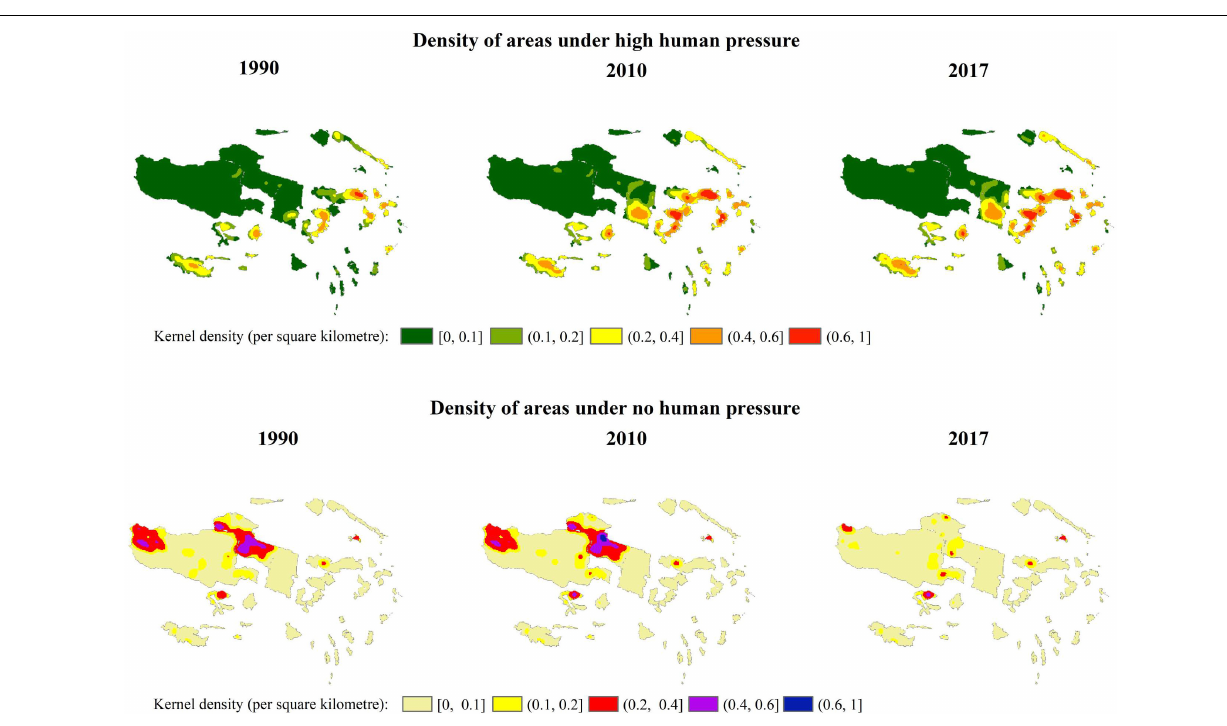
Frontiers in Ecology and Evolution |